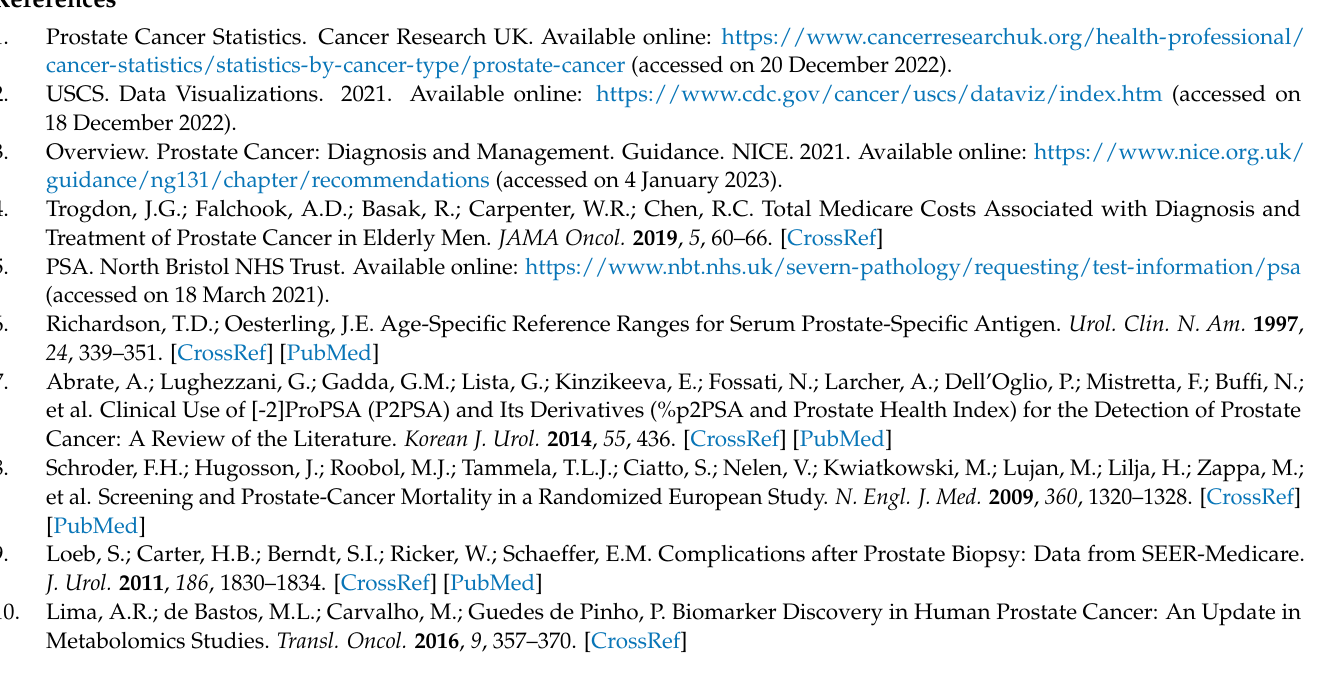
Figure S2: Three-component PCA illustrating separation of PCa-Post and PCa-ND